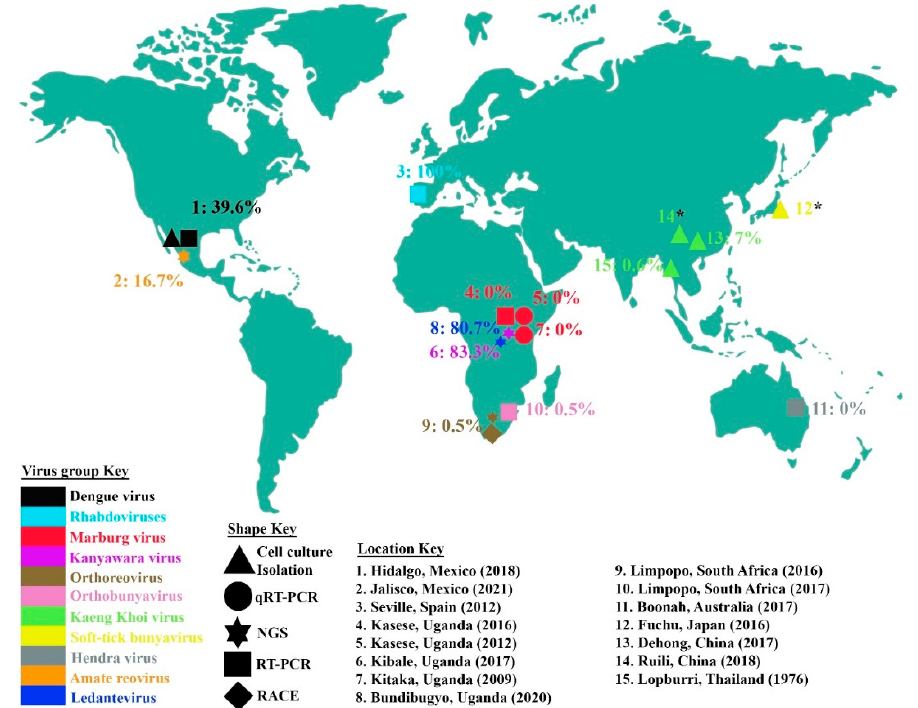
Figure 1. Locations from which bat ectoparasites for virus characterization were collected. The proportions of ectoparasites or ectoparasite pools found positive for the virus or virus family under study are also indicated, and virus or virus families are color-coded. The five differently shaped points show the different methods used for virus identification, including cell culture isolation, quantitative real-time PCR, reverse transcriptase PCR, next-generation sequencing and rapid amplification of cDNA ends. For the locations with an asterisk (*), the virus prevalence is indeterminate. The year for each study is also indicated.